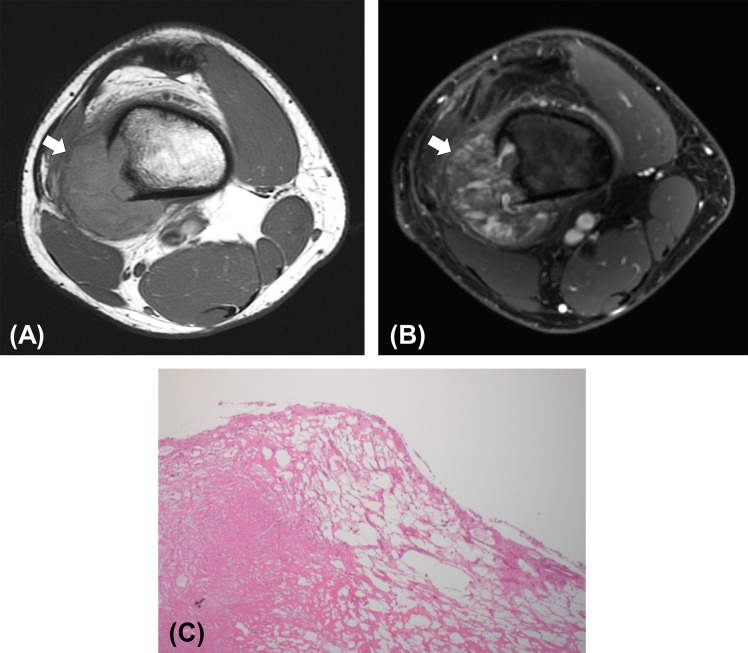
T1-enhancement of ferumoxytol in dilated vascular sinusoids of a teleangiectatic osteosarcoma.T1 weighted pre and post contrast images with corresponding histology. A) Non-contrast, nonfat-saturated, T1 weighted axial image of the femur shows a telangiectatic osteosarcoma (arrow). Tumor appears featureless. B) Fat-saturated, T1 weighted axial image of the same tumor after administration of 5 mg Fe/kg ferumoxytol. Tumor now shows hyperintense fluid-fluid levels in cystic-vascular areas. C) Corresponding histology shows findings compatible with telangiectatic osteosarcoma with numerous vascular sinusoids.